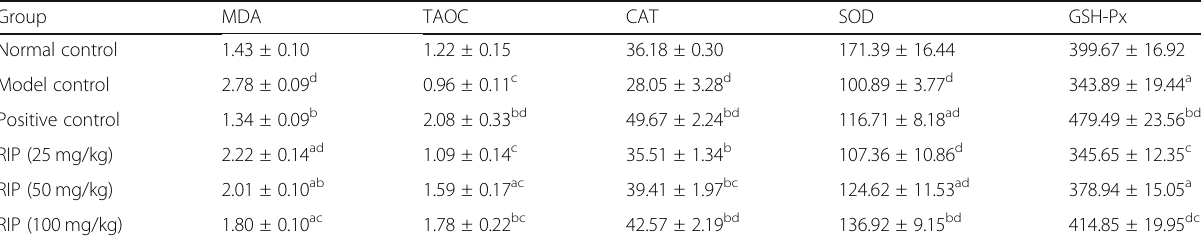
Table 5 Effects of different treatments on the activities of CAT (U/mg protein), SOD (U/mg protein), GSH-Px (U/mg protein) and levels of MDA (nmol/mg protein) and TAOC (U/mg protein) in the livers of aging mice Group MDA TAOC CAT SOD